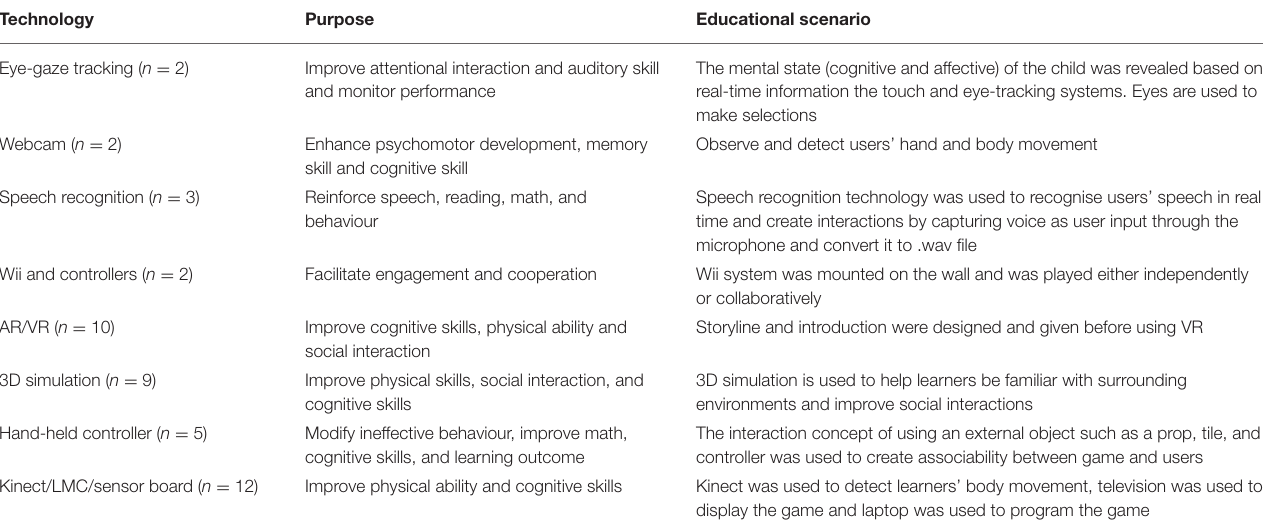
TABLE 3 | Learning purposes and scenarios with different types of technology within game-based